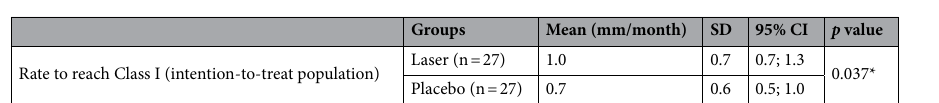
Table 4. Mean differences in evaluation of the VAS scores at D1, D2 and D3 in the two groups. VAS visual analog scale, D1 day 1, D2 day 2, D3 day 3, SD standard deviation; significant at p < .05.